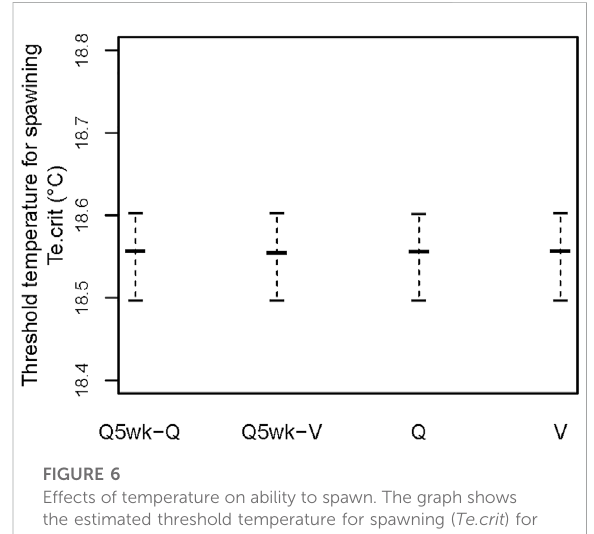
FIGURE 6 Effects of temperature on ability to spawn. The graph shows the estimated threshold temperature for spawning ( Te.crit ) for each of the four model structures as described for Figure 5. Horizontal bars show the median parameter estimate with whiskers encompassing the 95% credible interval for the estimate.